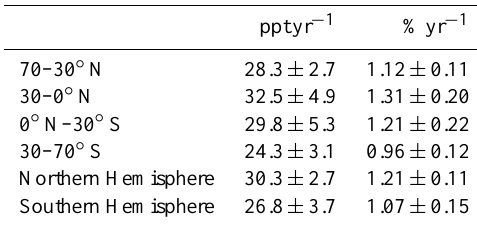
Table 7. The trends in the mean stratospheric total fluorine volume mixing ratio between 2004 and 2009 for different latitude bands and the NH and SH. The error presented here is the 1- σ error of a least squares fit.